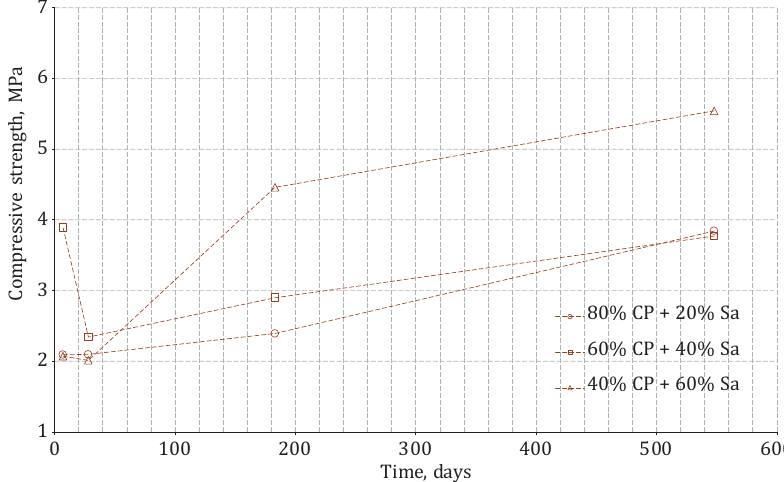
Figure 11. Updated compressive strength of samples (70% Portland cement + 30% fly ash) after Zakarka et al. (2019)